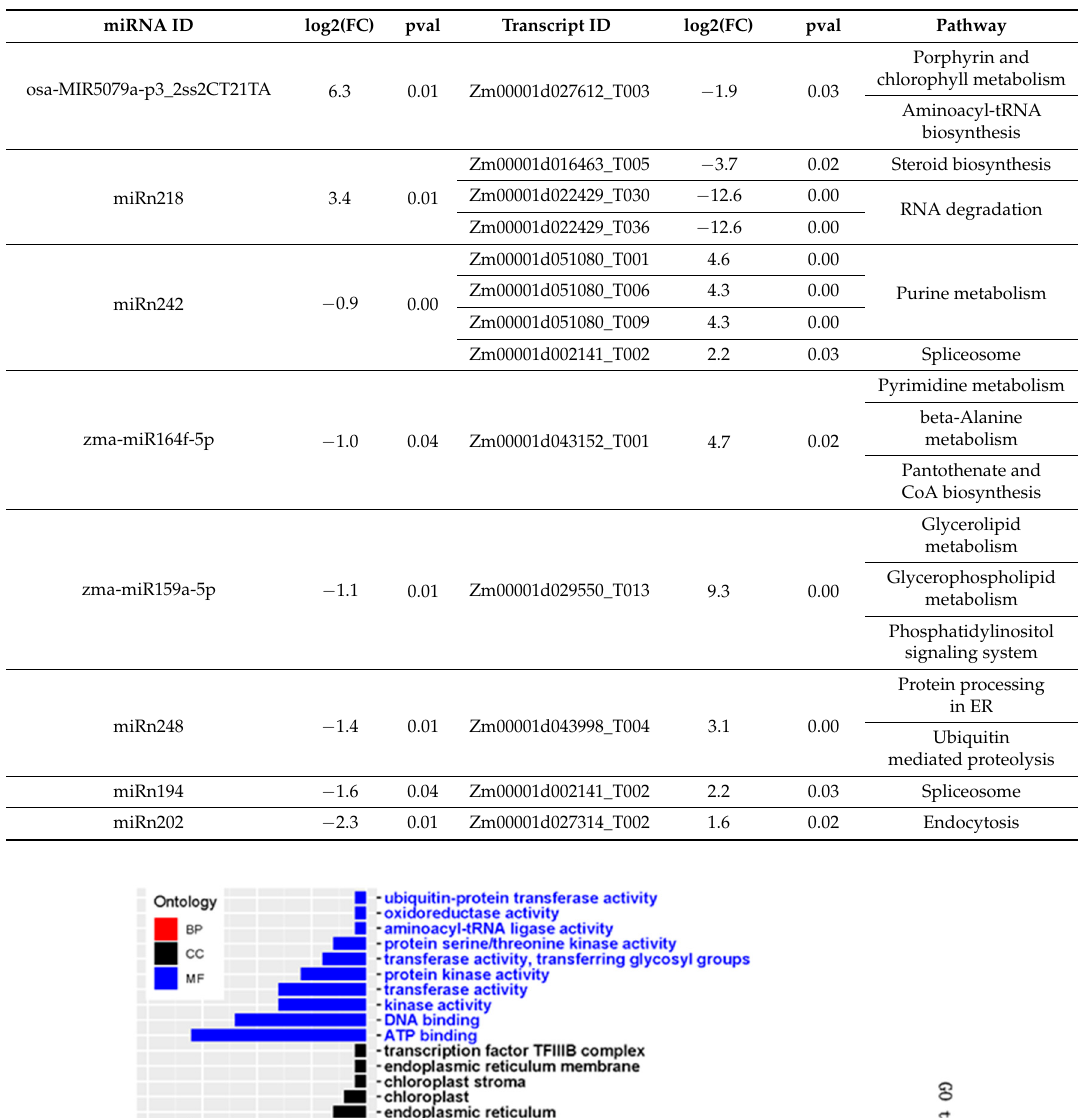
Table 4. List of the miRNA-mRNA pairs related to vital pathway.